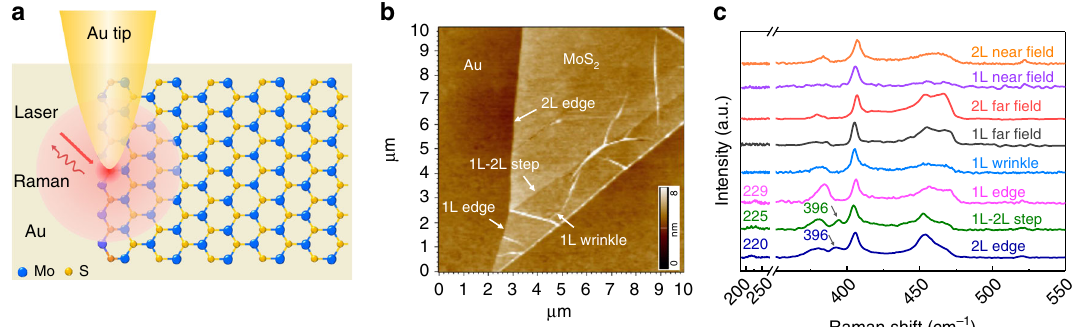
Fig. 1 TERS study of edge defects in the atomically thin MoS 2 . a Schematic of a TERS con fi guration using an Au-coated AFM tip and an atomically smooth Au fi lm with monolayer (1 L) or bilayer (2 L) MoS 2 on the surface. b AFM image of the mechanically exfoliated MoS 2 with different types of 1D defect on an Au substrate. c Raman spectra of four 1D defects and the basal plane in MoS 2 marked in b , when the tip was approached and retracted. Note that these spectra are the near- fi eld spectra and have been subtracted with the far- fi eld signal, as well as the tip-enhanced photoluminescence background from MoS 2 and surface plasmon resonance (SPR) from the TERS tip. The intensity is normalized to the A 1g peak for